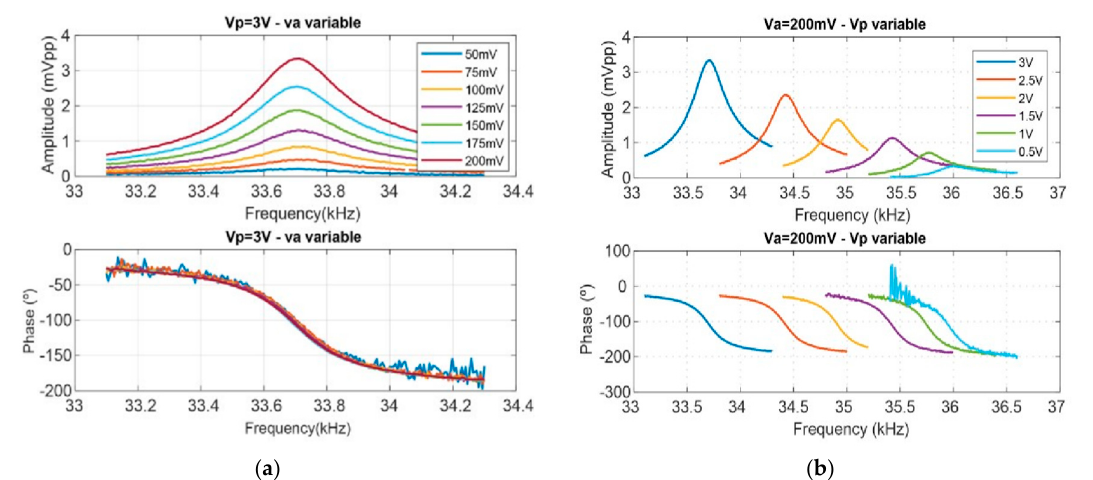
Figure 3. ( a ) Several frequency sweeps performed with a bias voltage of 3 V and different driving voltages. ( b ) Characterization of the resonator for different bias voltages and a fixed driving voltage of 200 mV.